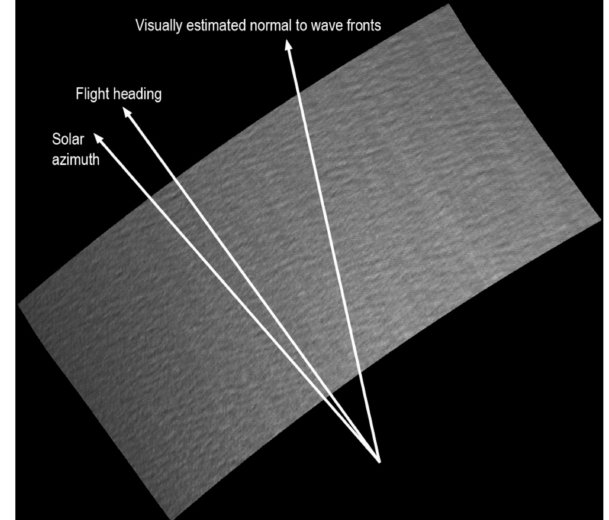
Fig. 7. This image was acquired 28.5min after the MISR nadir im- age was acquired. The ER-2 with AirMSPI aboard was flying to- ward the northwest very close to the principal scattering plane, and a 21-angle image sequence was acquired. Here, sunglint illuminates the surface wave